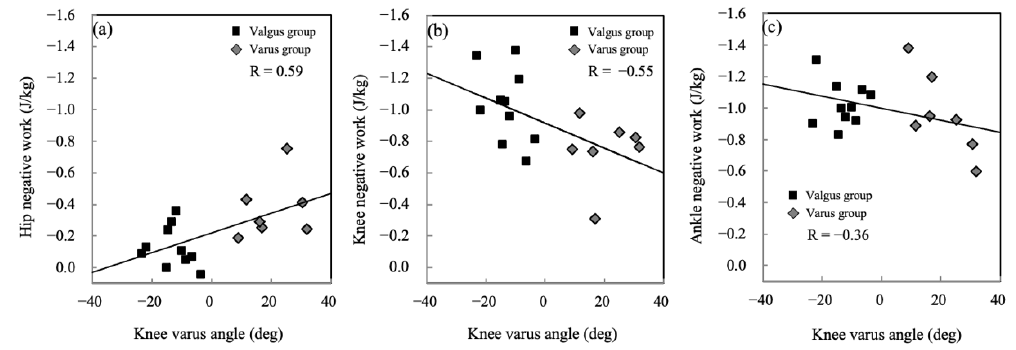
Figure 4. The negative mechanical work in lower extremity joints and knee valgus and varus angles. The mutual relations between negative mechanical work done at the hip ( a ), knee ( b ), and ankle ( c ) and the knee valgus/varus angles of each participant.